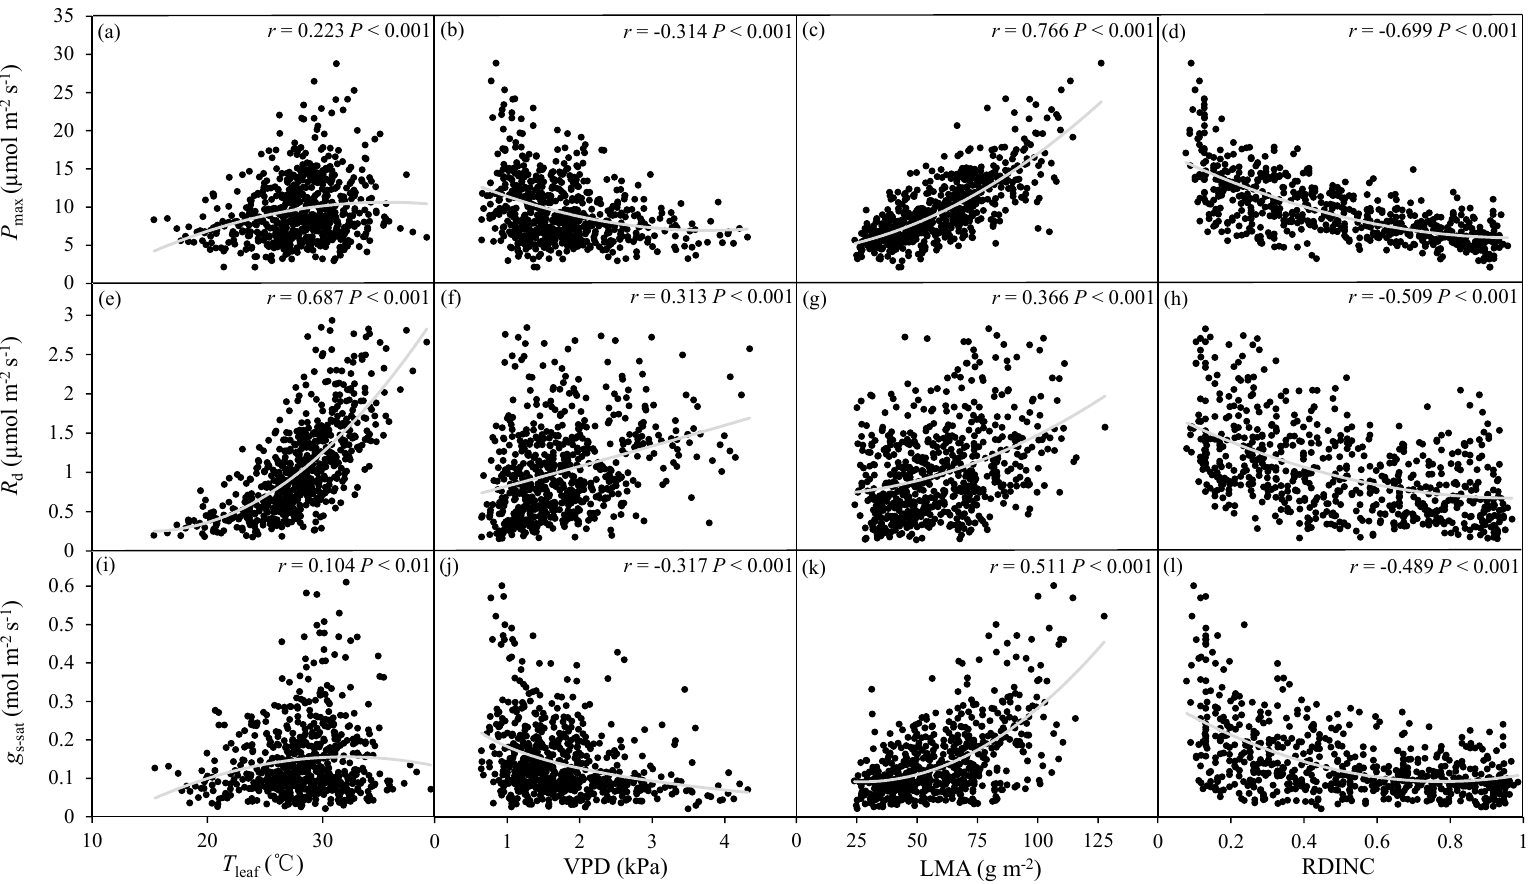
Figure 3. The relationships: ( a – d ) between the light-saturated net photosynthetic rate ( P max ) and leaf temperature ( T leaf ), vapor pressure deficit (VPD), leaf mass per area (LMA) and relative depth into the crown (RDINC); ( e – h ) between dark respiration ( R d ) and T leaf , VPD, LMA and RDINC; ( i – l ) between light-saturated stomatal conductance ( g s-sat ) and T leaf , VPD, LMA and RDINC. The r values are Spearman’s correlation coefficients. The solid gray line represents the fitting results based on polynomial equations.